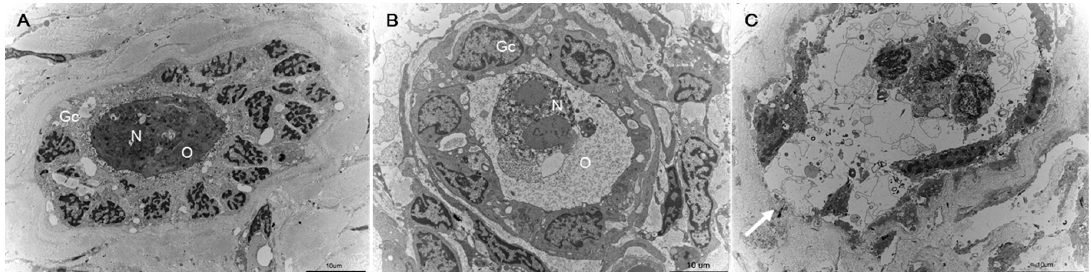
Figure 7. Morphological analysis of primordial follicles from human ovarian tissues using transmission electron microscopy. ( A ) The primordial follicle from the fresh ovarian tissue (control group) ( B ) The primordial follicle from cryopreserved with slow freezing and thawed group. A round oocyte (O) tightly connected to the surrounding granulosa cells (Gc) is evident. The cytoplasmic membrane and envelope of nucleus (N) are intact. ( C ) Follicle from vitrified and thawed group. The follicle from vitrification group was deformed and destructed by ice crystal formation after thawing (white arrow), whereas the follicle from the control group and the slow freezing group were intact.